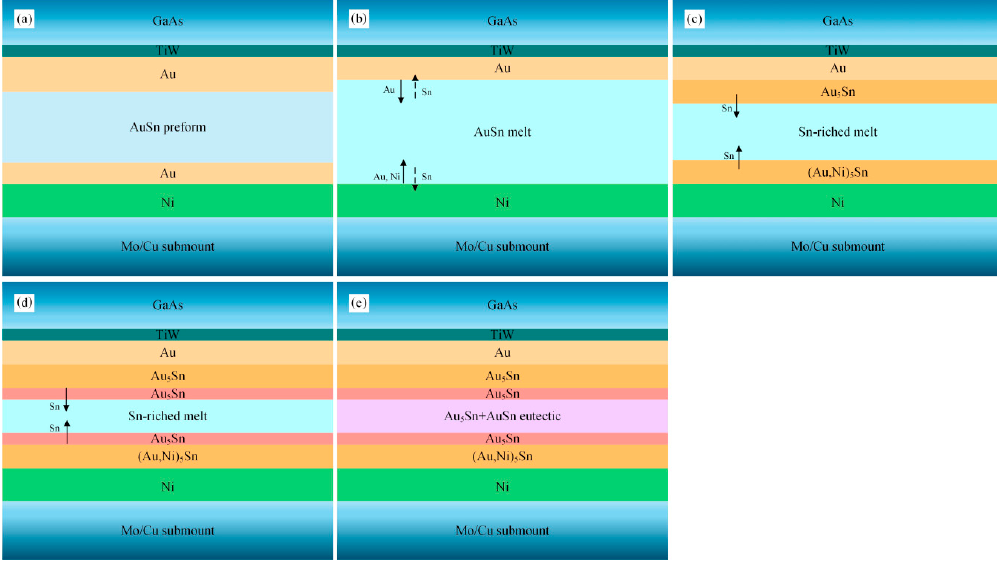
(Figure 9). Therefore, a larger and thinner preform was preferred to avoid the local lack of Au-Sn solder.